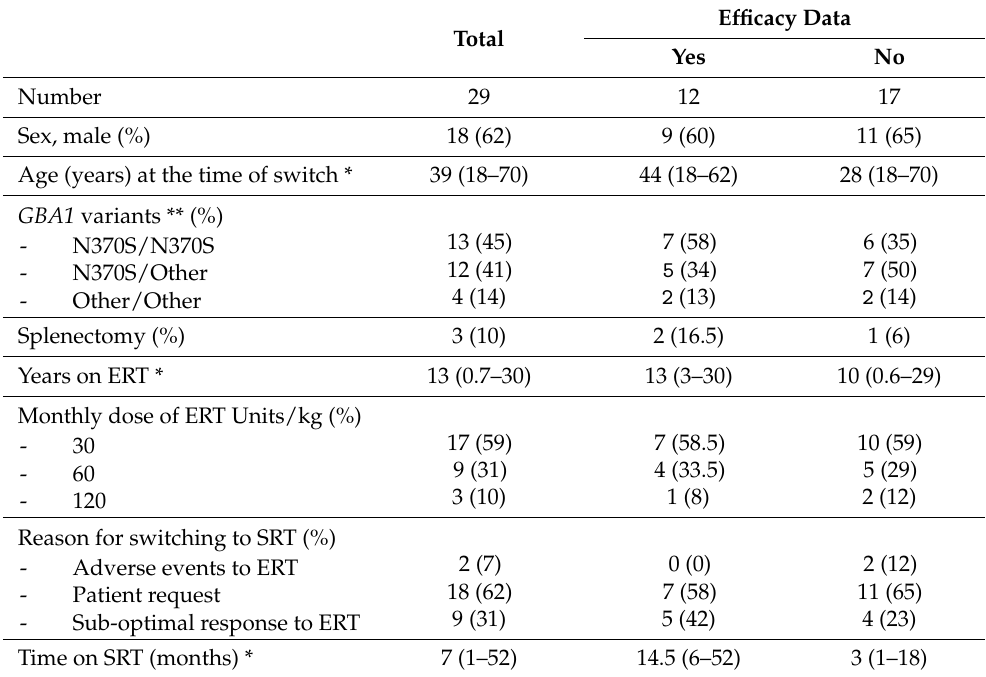
Table 1. Clinical characteristics of patients with GD1 switching to eliglustat.